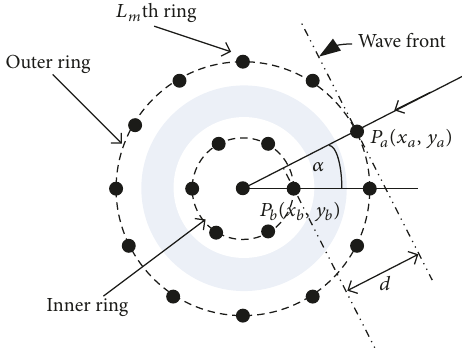
Figure 2: Geometry of CECCAA